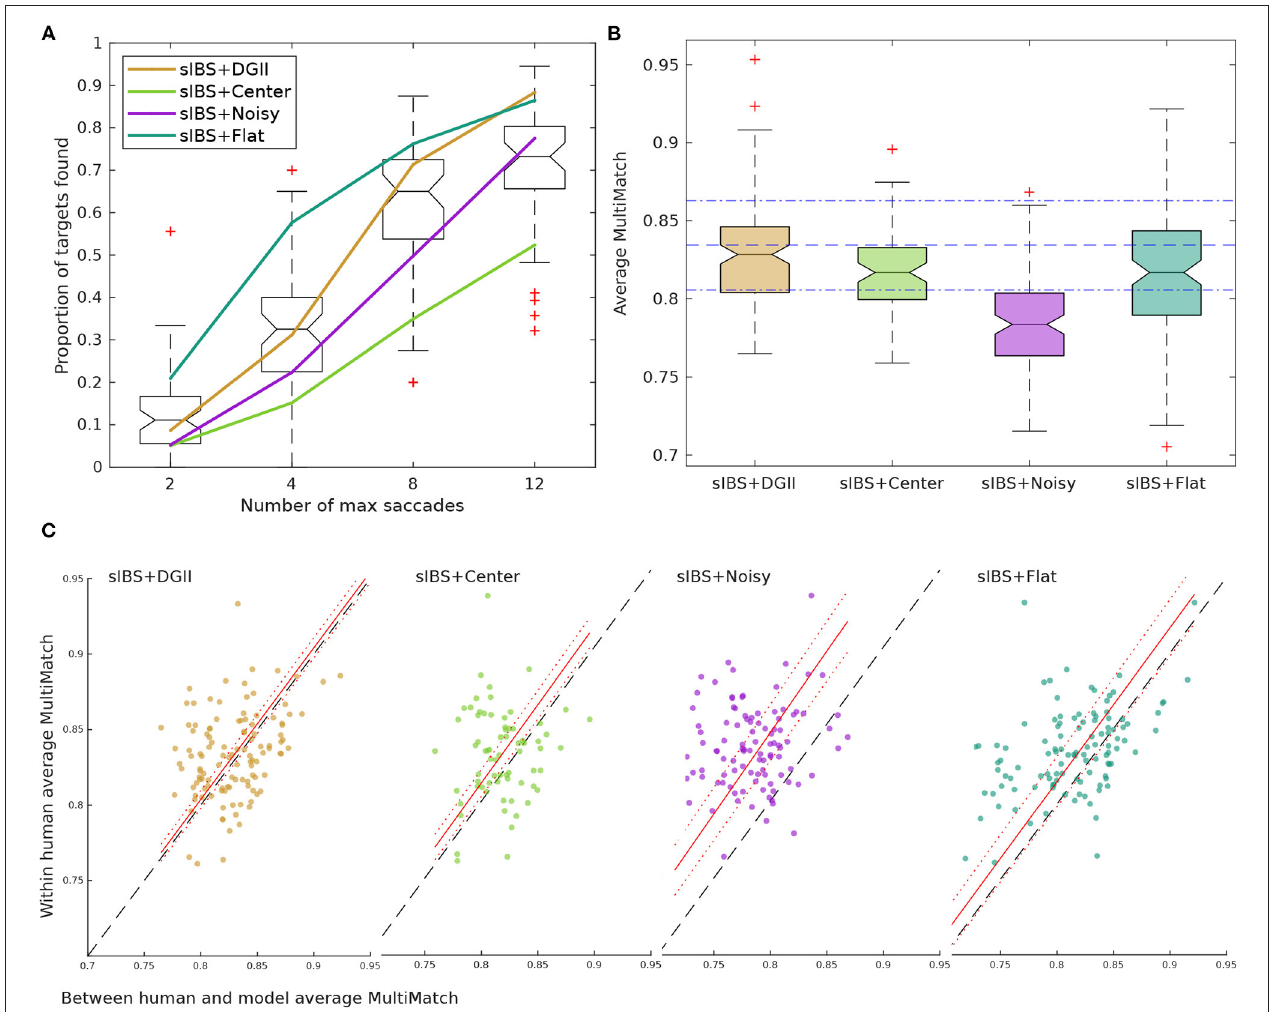
FIGURE 5 | Saliency maps as priors. (A) Proportion of targets found for each threshold considered. Human behavior is presented as a boxplot. The performance achieved by the models using sIBS with different prior distributions. (B) Distribution of average MultiMatch similarity score (vector, direction, position, and length) for each strategy (higher is better). Blue horizontal lines represent the mean and standard deviation scores for humans (0.83 ± 0.02). (C) Mean within-human MultiMatch scores against the mean between human and models MultiMatch scores. Linear regression with intercept = 0 was performed (red lines; see Table 1 ). Each dot represents an image of the dataset. Only trials where the target was found are considered in (B,C) for computing MultiMatch